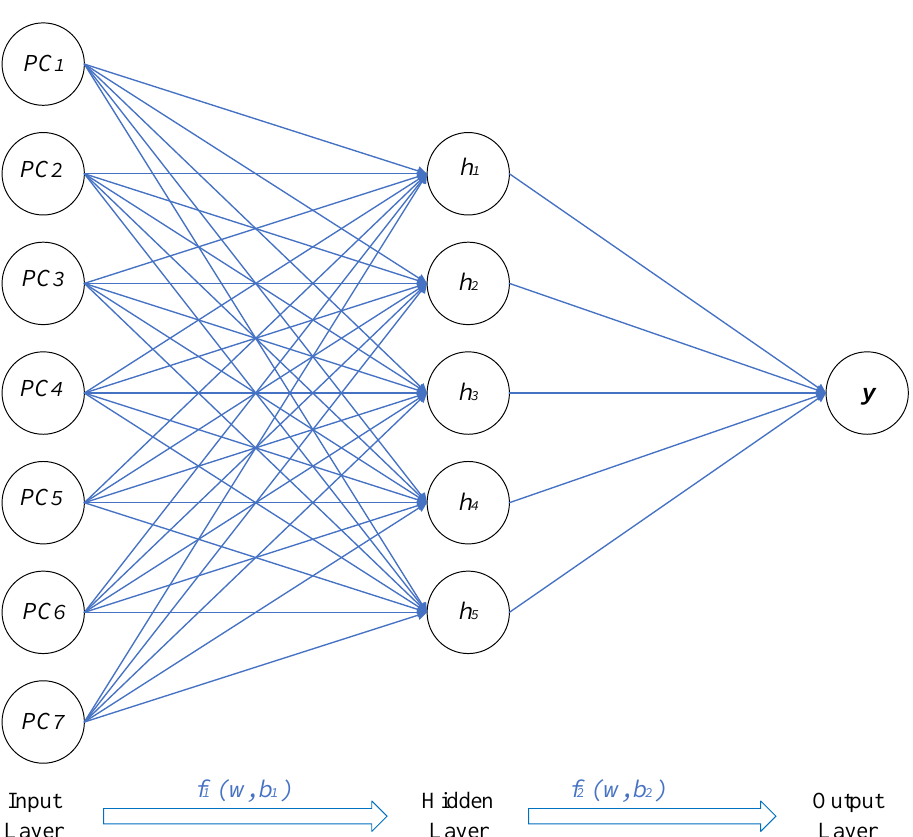
Figure 5. Selection for hidden layer neurons.